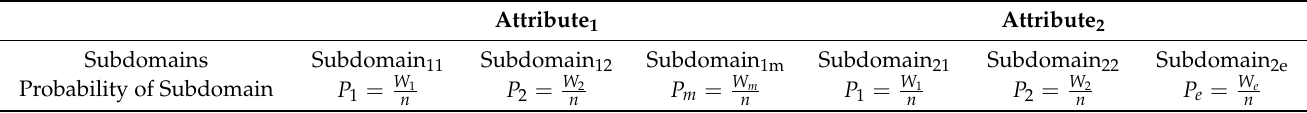
Table 5. Subdomain Probability Vector